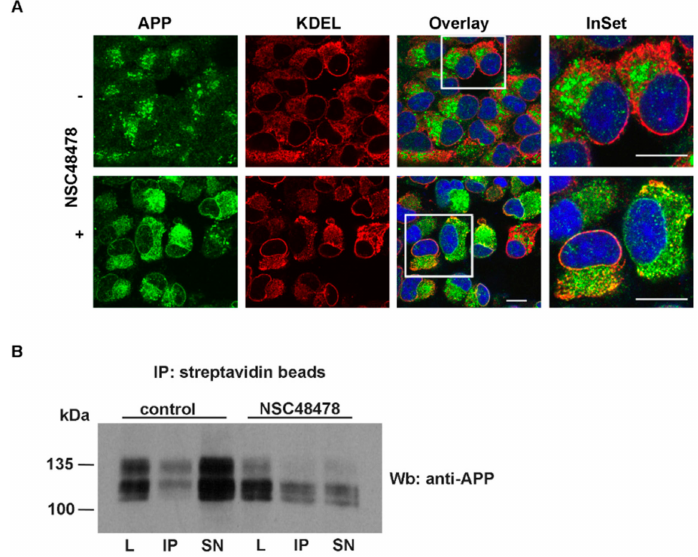
Figure 4. NSC48478 inhibitor induces partial ER (Endoplasmic Reticulum) retention of APP without a ff ecting cell surface distribution of APP. ( A ) GT1 cells grown on coverslips, either untreated or treated with NSC48478 for 24 h, were subjected to immunofluorescence analysis by using anti-KDEL and anti-APP antibodies. Colocalization between APP and KDEL was then measured as indicated in the methods section. Plus ( + ) and minus (-) indicate the presence or absence of the compound. Scale bars, 10 µ m. ( B ) Cell surface proteins were biotinylated at 4 ◦ C in control (without inhibitor) or after treatment with NSC48478, and were recovered from cell lysates by immunoprecipitation with streptavidin-beads. Total (40 µ g of total cell lysates) and cell surface proteins (IP from streptavidin beads), were loaded on gel and processed for SDS-PAGE and ECL. APP was immunodetected by blotting with A8717 Ab. L: cell lysate; IP: immunoprecipitated biotinylated proteins by streptavidin beads; SN: